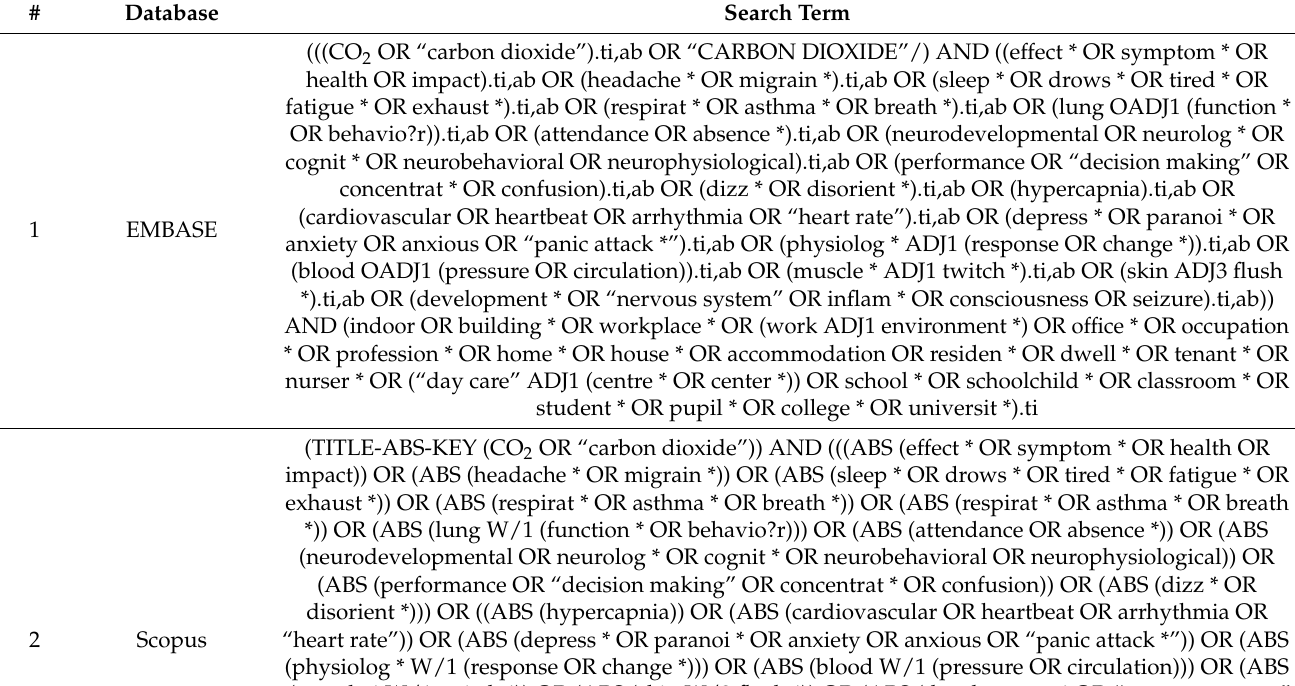
Table A1. Search strings used for the literature